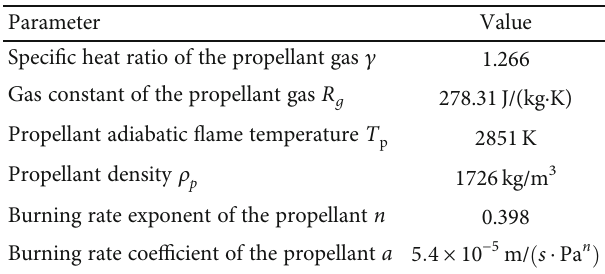
Table 3: Physical parameters for the simulation of pressure evolution in the combustion